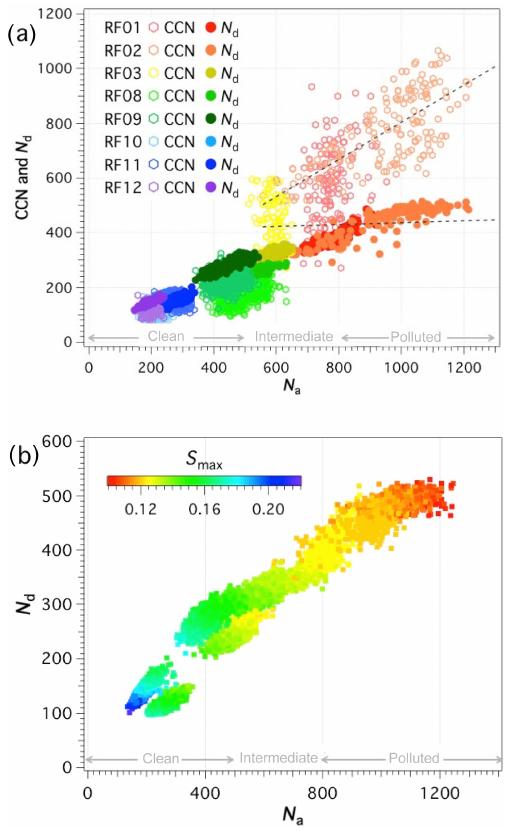
Figure 3. (a) The predicted droplet number ( N d ; cm − 3 ) and mea- sured CCN (cm − 3 ) at 0.1% supersaturation as functions of marine- boundary-layer aerosol concentration ( N a ; cm − 3 ) for all flights. (b) N d against N a in the MBL for all flights, colored by maximum in- cloud supersaturation ( S max ).